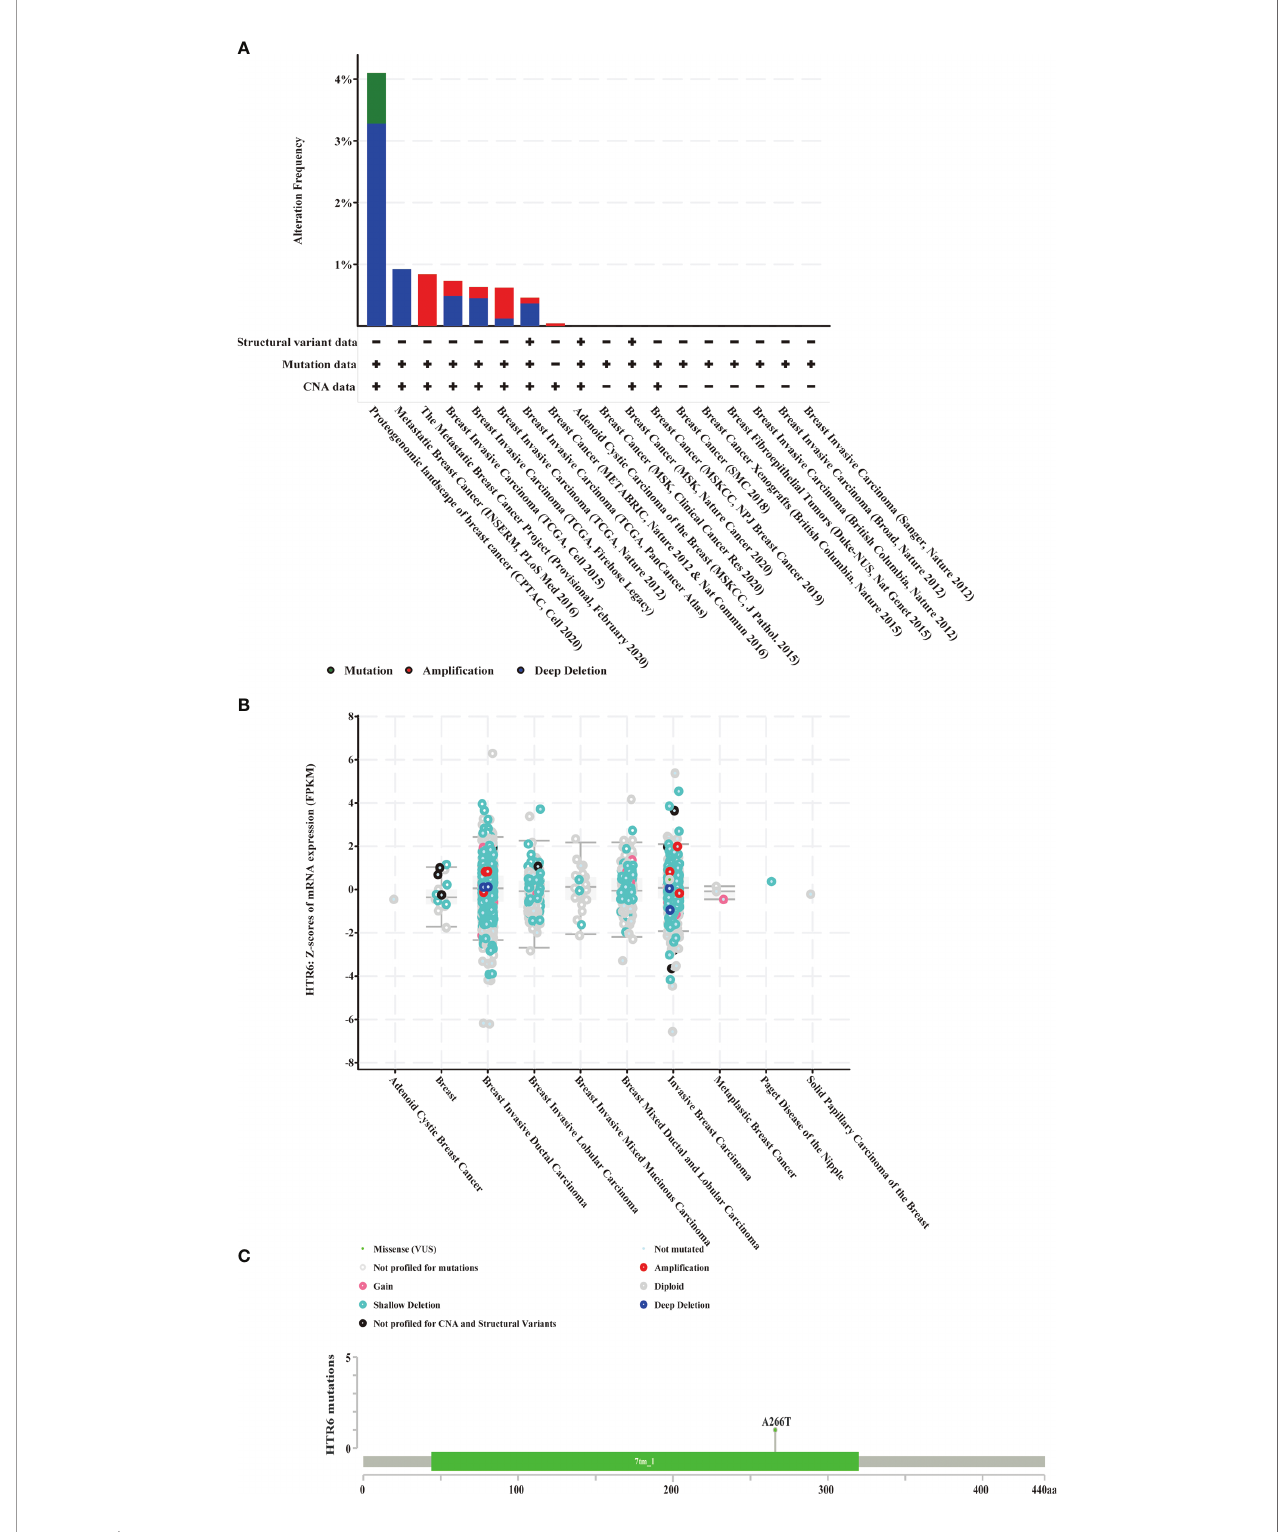
FIGURE 9 | Deep deletion of HTR6 in breast cancer was possibly relevant to the down-regulation of HTR6. (A) The distribution of HTR6 mutations in different breast cancer studies. (B) The correlation between HTR6 mutations and expression. (C) The mutation site of HTR6 in breast cancer